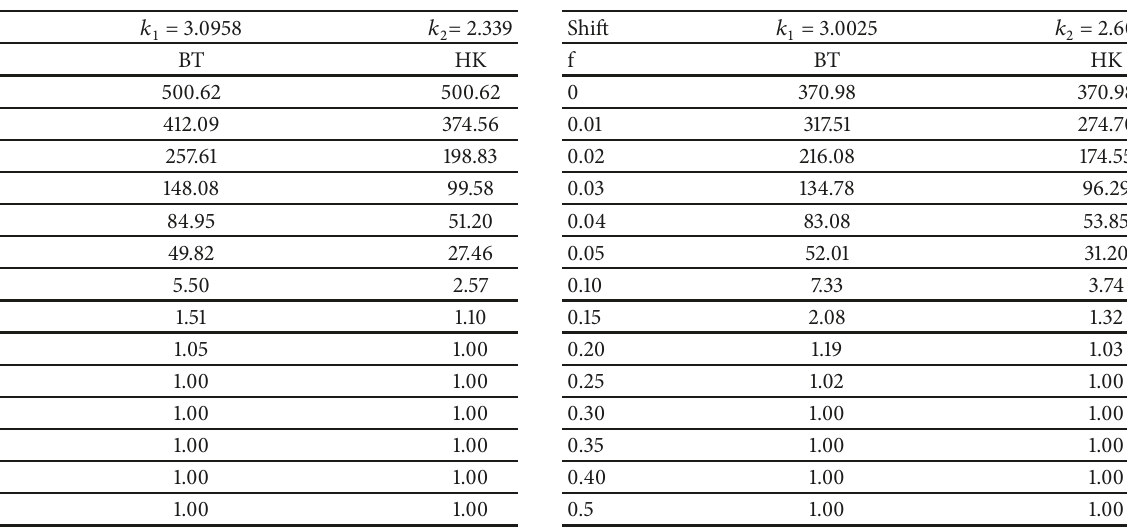
Table 14: ARLs for proposed repetitive EWMA-RSS control charts using exponential ratio-type estimators, for 𝜌 = 0.50 when 𝑟 𝑜 is 500 at 𝜆 = 0.1.